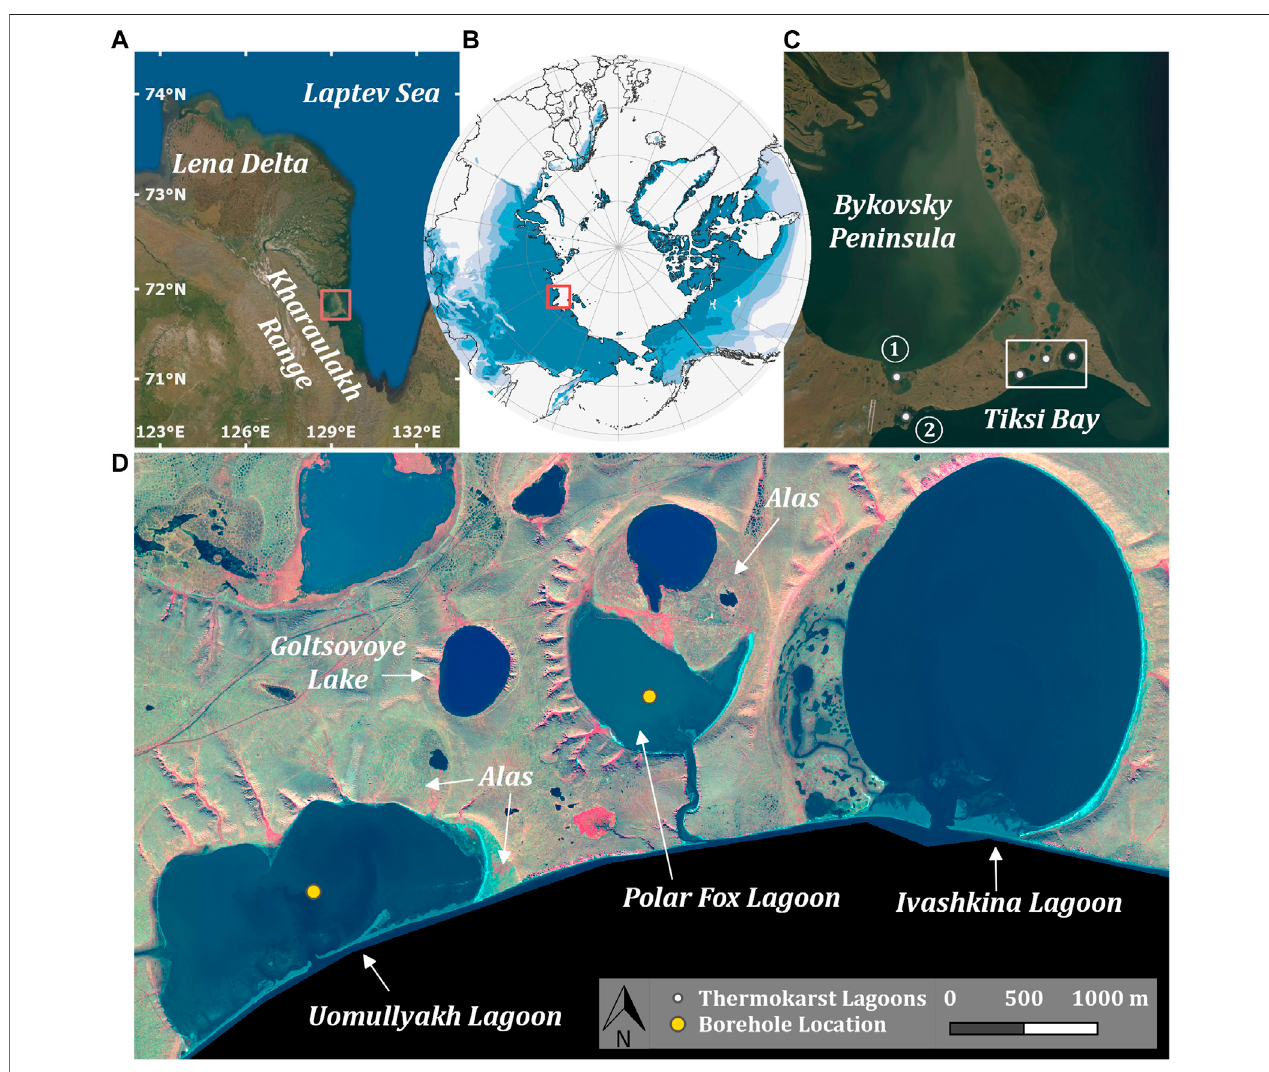
FIGURE1| BykovskyPeninsulainNortheastSiberia,southofLenaDelta (A,B) .BoththeStepanenko ① andSafroneeva ② lagoons (C) aswellastheUomullyakh, PolarFox,andIvashkinalagoonsarelocatedatthesoutherncoastoftheBykovskyPeninsula (D) .ThedrillinglocationsinthelagooncentersofUomullyakhandPolarFox lagoonsareindicatedbyyellowdots (D) .Sourceimagery: (A,C) :ESRISatelliteWorldImageryb:PermafrostextentregionsbasedonBrownetal.(1997) (D) WorldView3 false colour satellite image (8-5-3), acquired 2016-09-02.